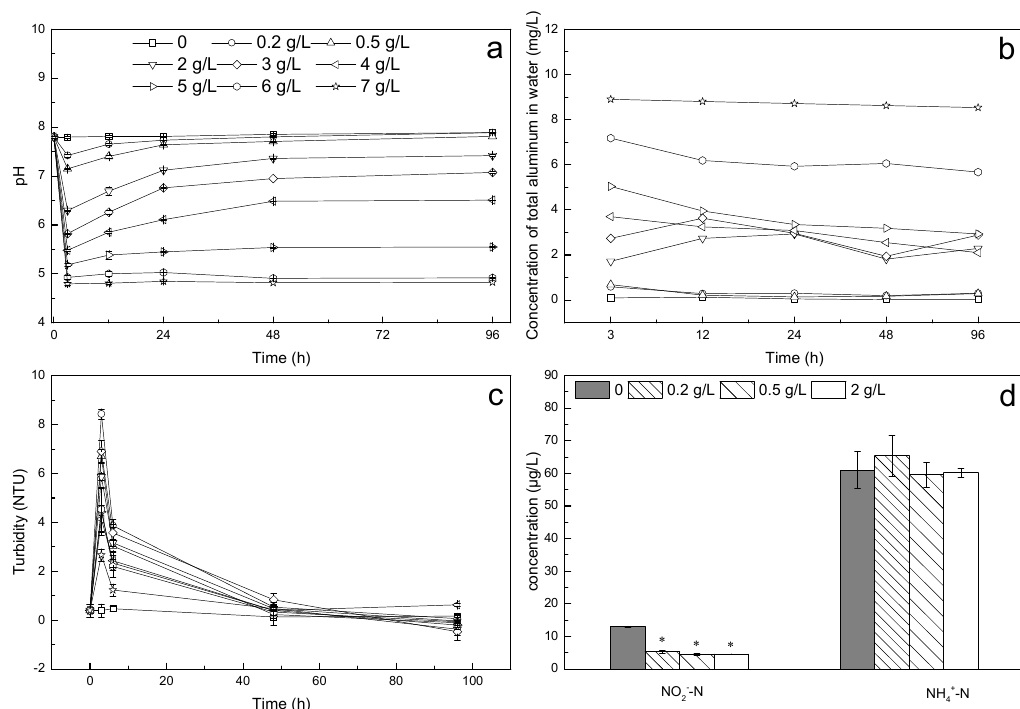
Figure 5. Changes in the water quality parameters with time after the addition of PAC-MC. ( a – c ) pH, total aluminum content, and turbidity changes over time. ( d ) Contents of NO 2 − -N and NH 4+ -N in each group at 96 h. Mean ± SD; ANOVA, Tukey; * significant difference compared with control at p < 0.05.